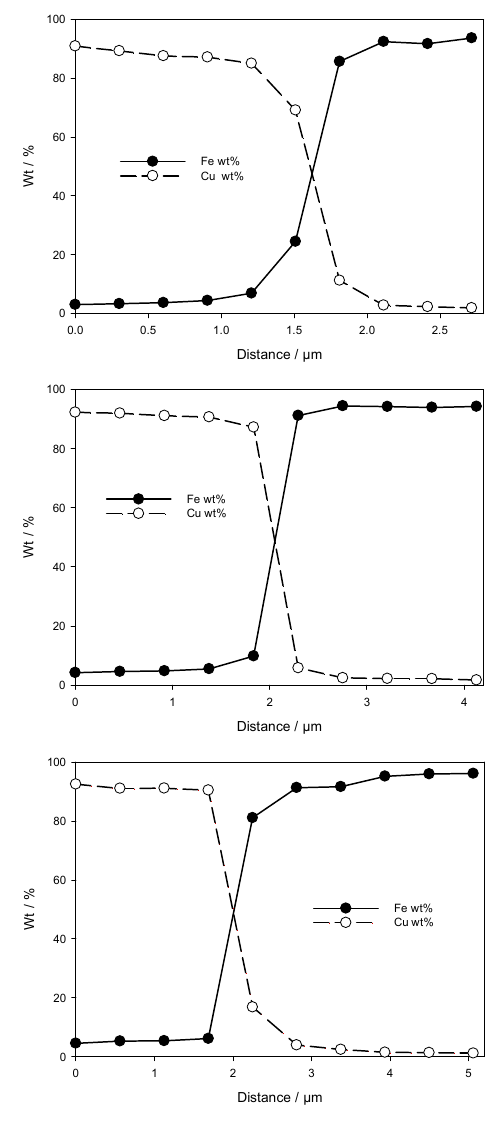
Figure 4. Changes in Cu and Fe elements of Cu–steel transition layer under different tempera- tures.